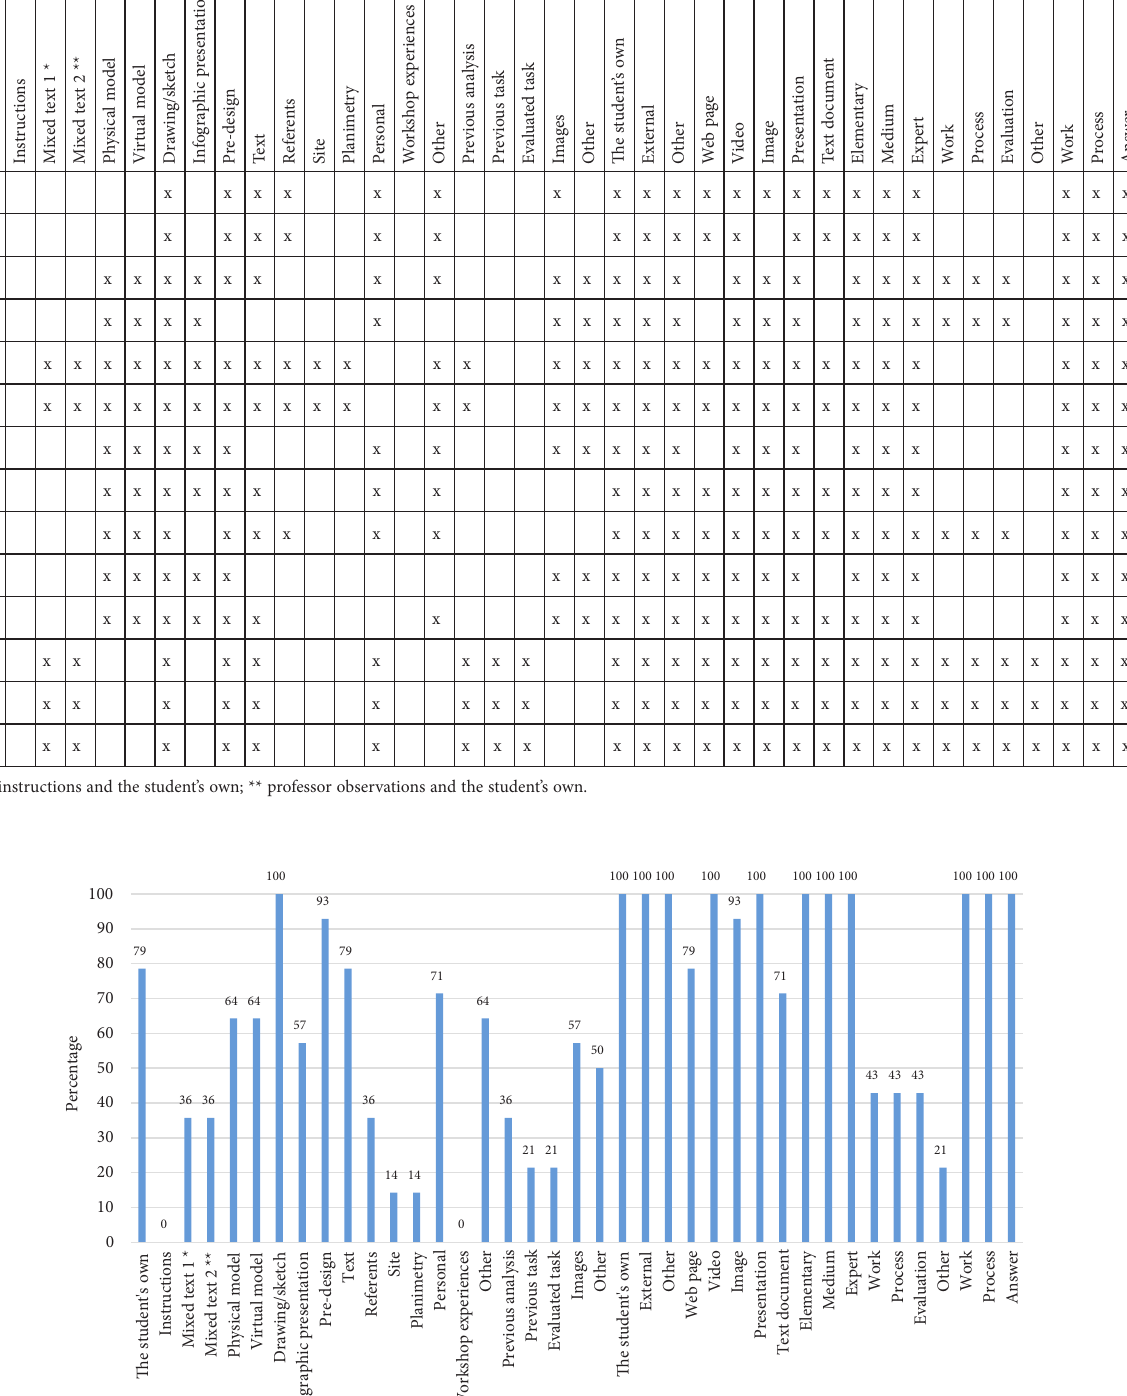
Table 3. Relationship between the different evidences categories and the component of architectonic learning (source: Authors, 2019) Texts Images t e n o n m p C o